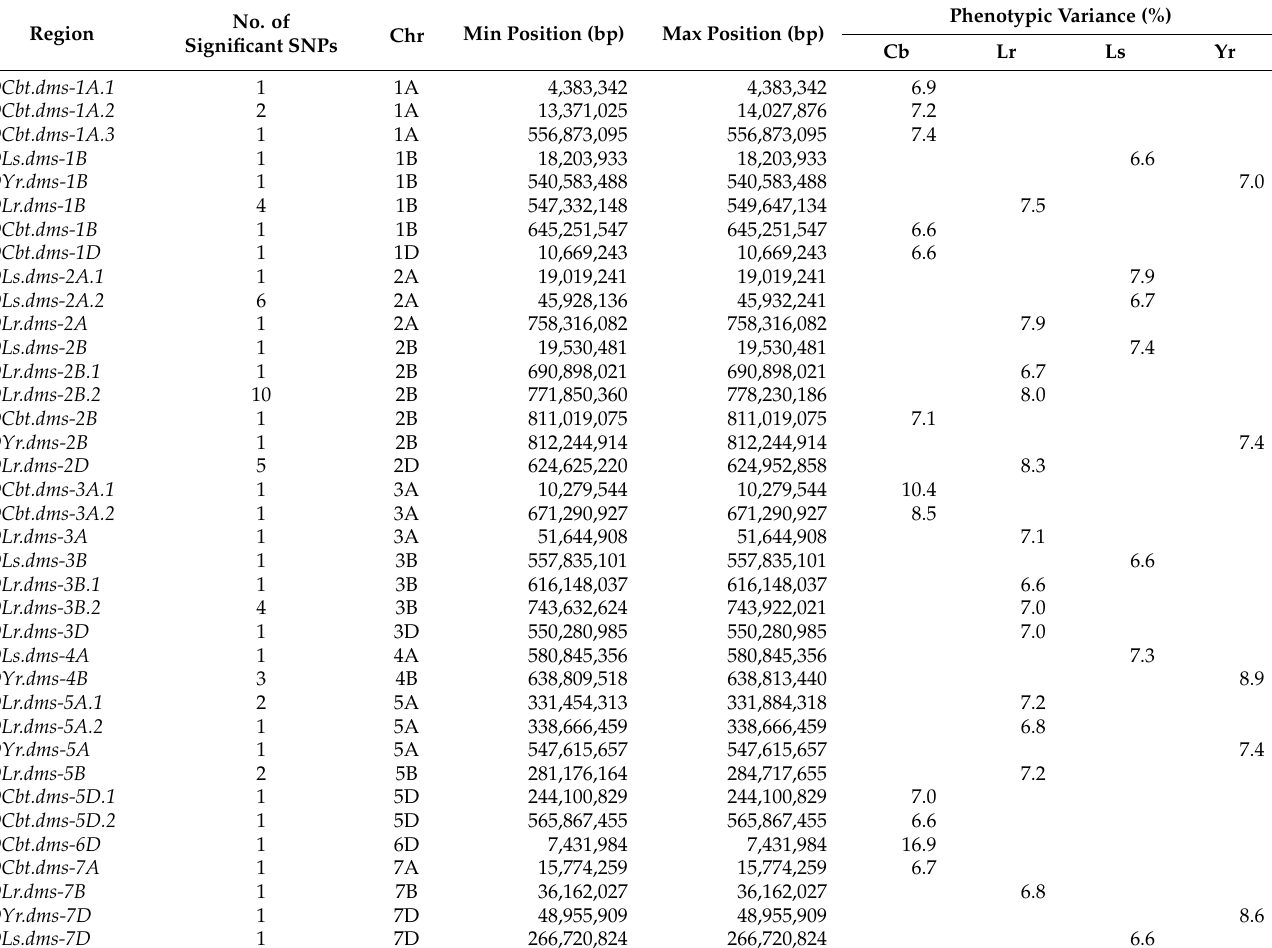
Table 2. Summary of the 37 genomic regions associated with stripe rust (Yr), leaf rust (Lr), leaf spot (Ls), and common bunt (Cb) resistance recorded in all combined environments. The chromosome (Chr) and physical position are based on the International Wheat Genome Sequencing Consortium (IWGSC) RefSeq v2.0. See Table S6 for